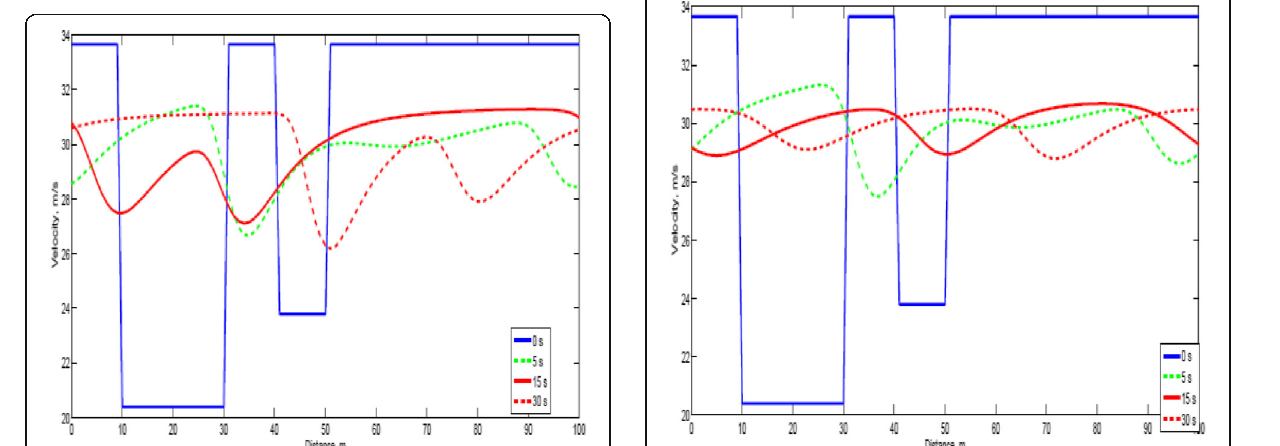
Fig. 4 The KG model velocity behavior with τ = 1 s